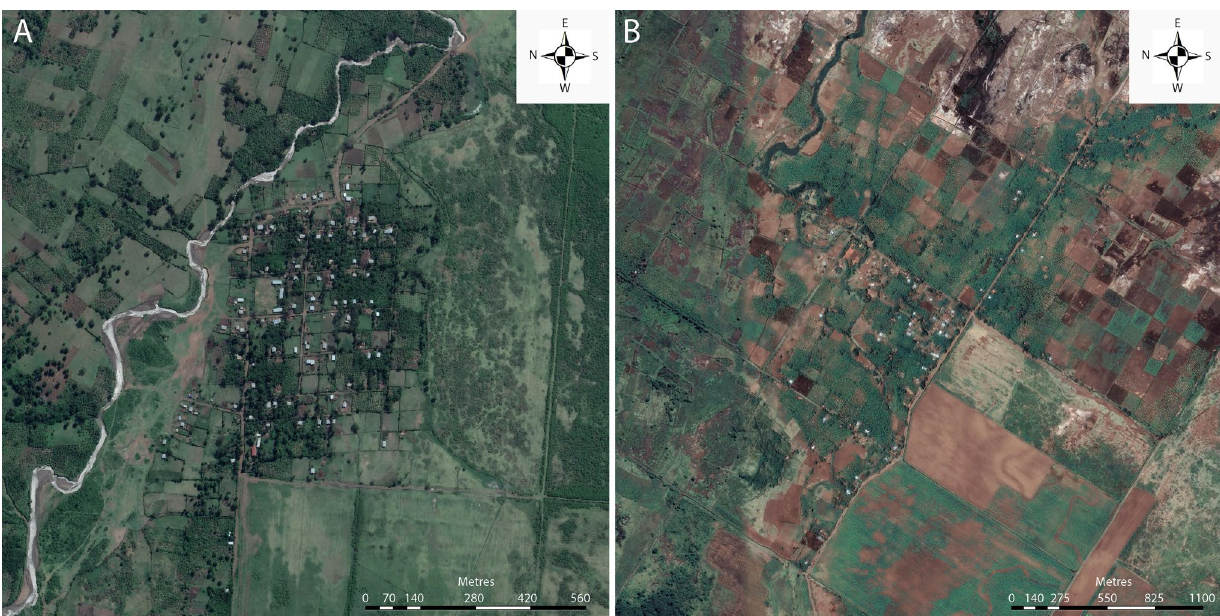
Figure 1. Aerial images of the two study villages, Abulo ( A ) and Magge ( B ). The two rural villages are situated within similar agricultural landscapes. Aerial images are taken at different times of the year, which is seen in the difference in crop cover in the two villages. The scale bars indicate distance (m). The aerial images were obtained using the open software Google Earth Pro (Version